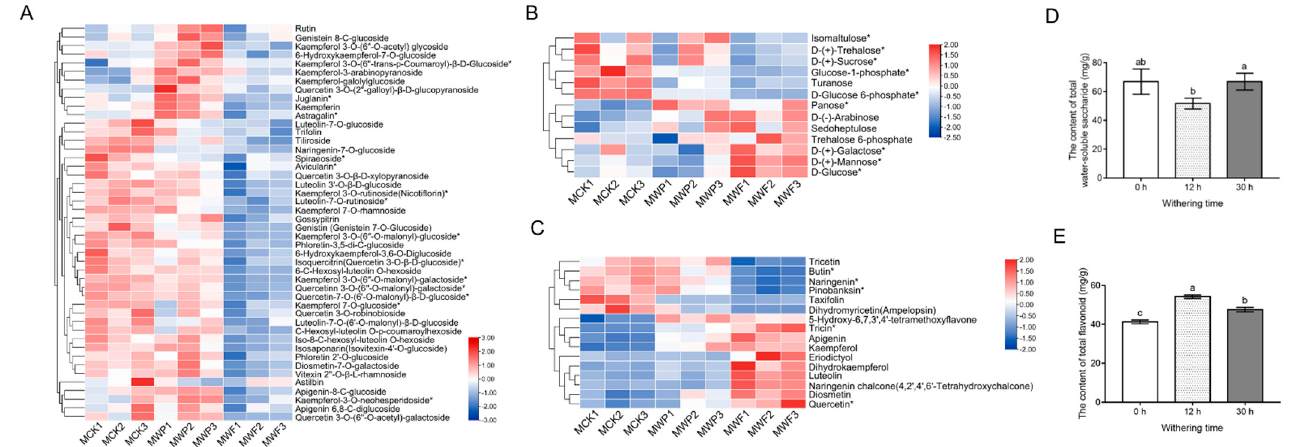
Figure 2. Heat map of the levels of differential nonvolatile compounds and content changes of flavonoids and water-soluble saccharides during the withering period. ( A ) Heat map of contents of flavonoid glycosides detected at different time periods. ( B ) Heat map of contents of water-soluble saccharides detected at different time periods. ( C ) Heat map of contents of flavonoid aglycones detected in different time periods. ( D ) The contents of total flavonoid at different time periods. ( E ) The contents of total water-soluble saccharides at different time periods. Each value represents the mean ± SD (n = 3). Values with different letters (a–c) differ from each other significantly ( p < 0.05). Note: * the isomeric labeling indicates that these compounds were very similar in structure and co-flux will occur in mass spectrometry, which can be used for preliminary identification, but cannot be clearly distinguished. MCK, MWP, and MWF represent metabolomic samples with withering times of 0 h, 12 h, and 30 h, respectively.